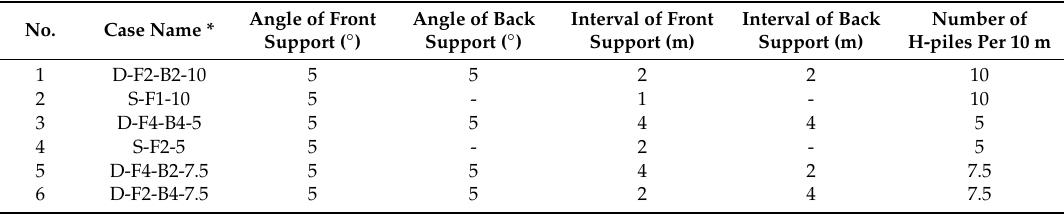
Table 3. Summary of the conditions used for numerical analysis.